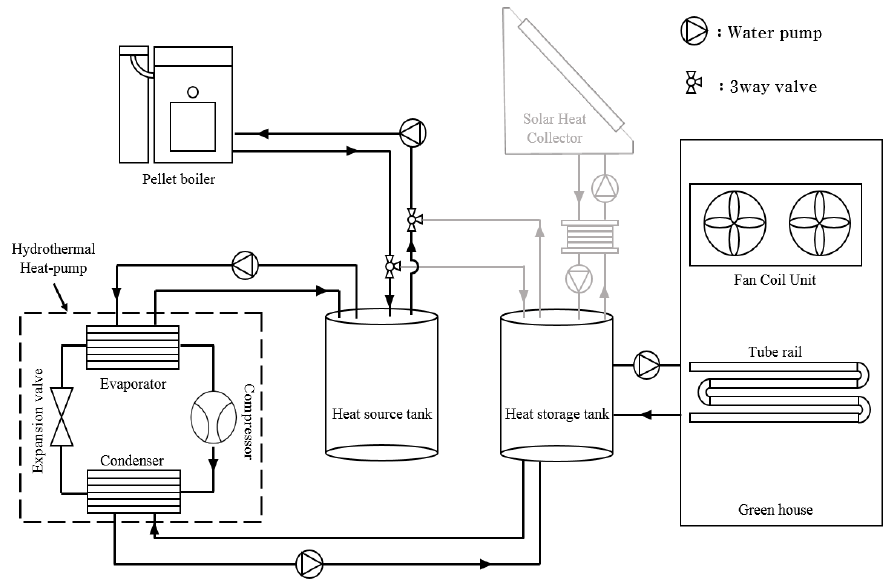
Figure 3. Schematic of hybrid system 1.